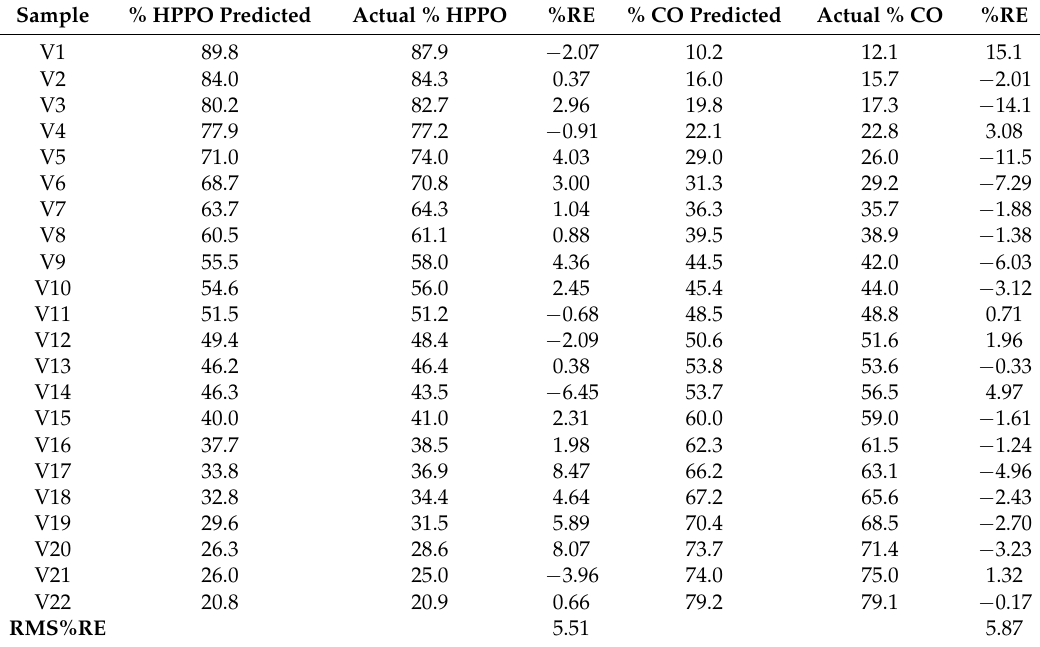
Table 3. Validation conducted for highly refined peanut oil (HRPO) adulterated with canola oil (CO). Sample